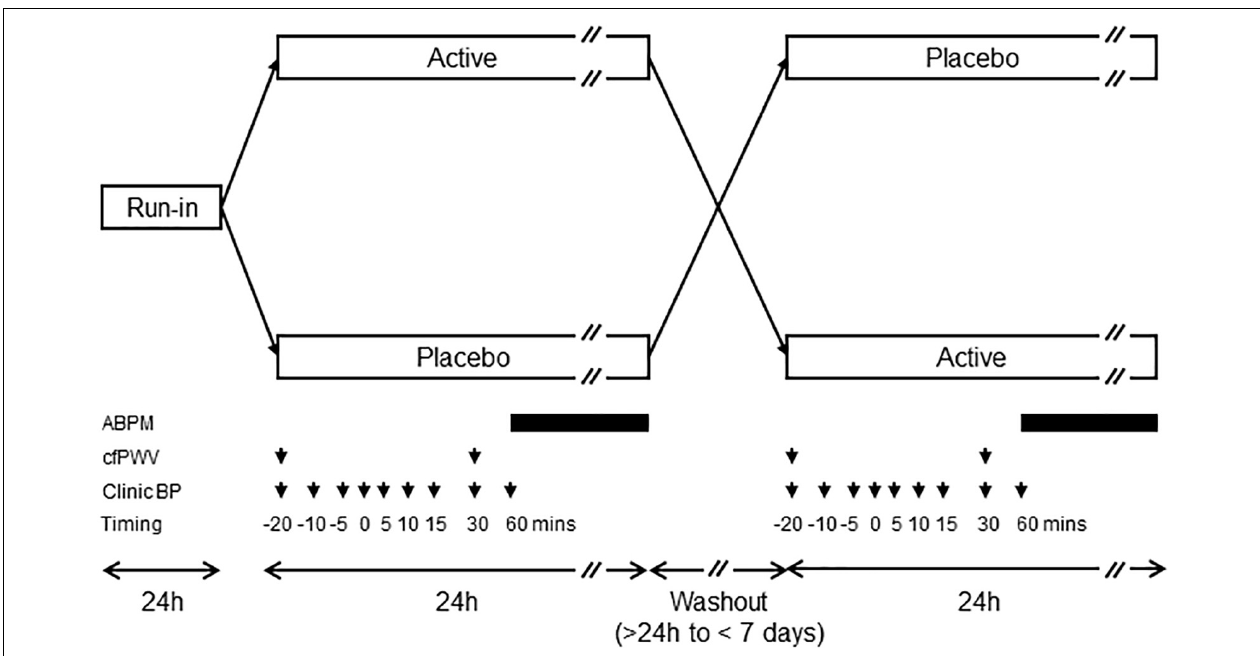
FIGURE 1 | Diagram showing crossover design. Timings of measurements of clinic blood pressure (BP), carotid-femoral pulse wave velocity (cfPWV), and ambulatory blood pressure monitoring (ABPM) with respect to administration of placebo or active juice (time = 0) are indicated by the arrows and bars, respectively. ABPM was performed every 30 min during the day and hourly during the night.